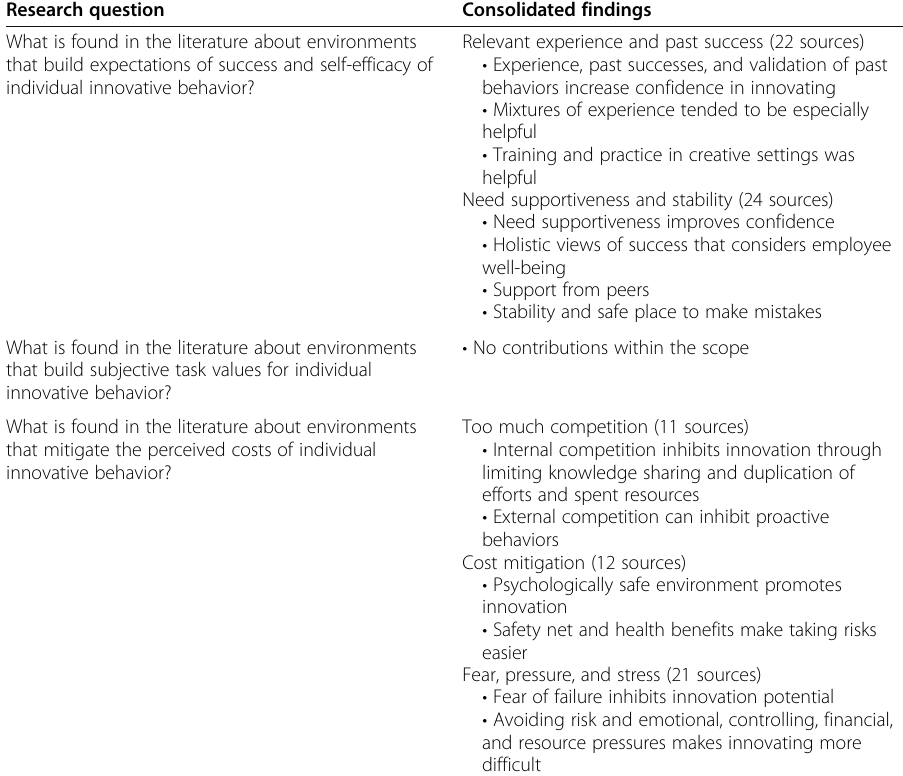
Table 6 Summary of research questions and consolidated themes Research question Consolidated